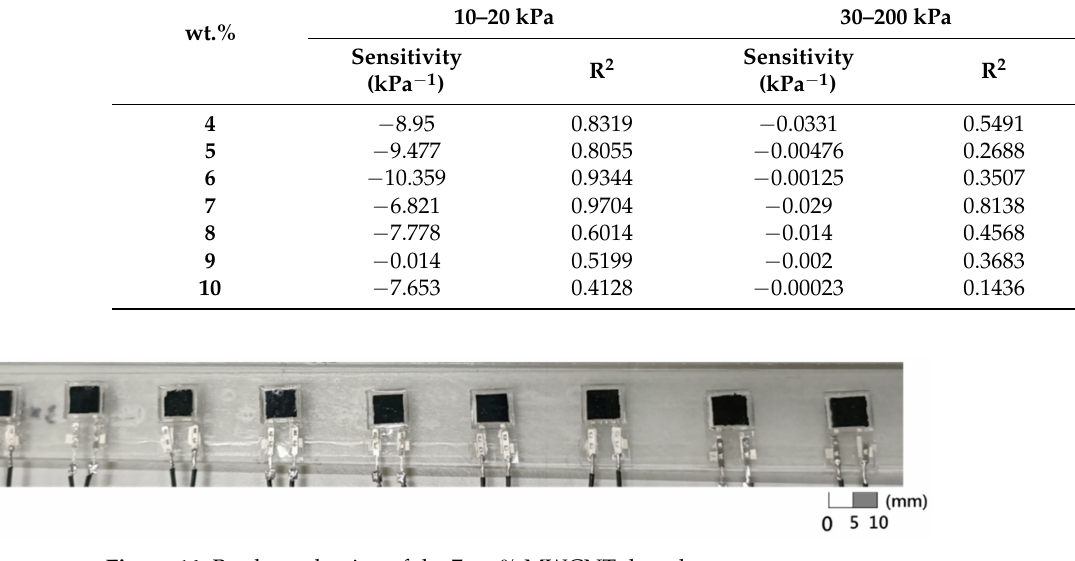
Figure 14. Batch production of the 7 wt.% MWCNT doped